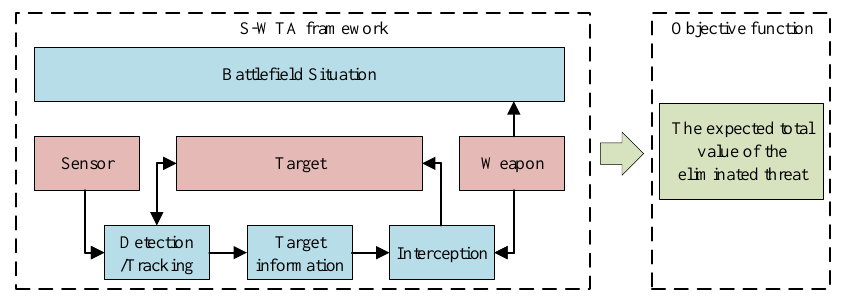
Figure 3. The dependent S-WTA